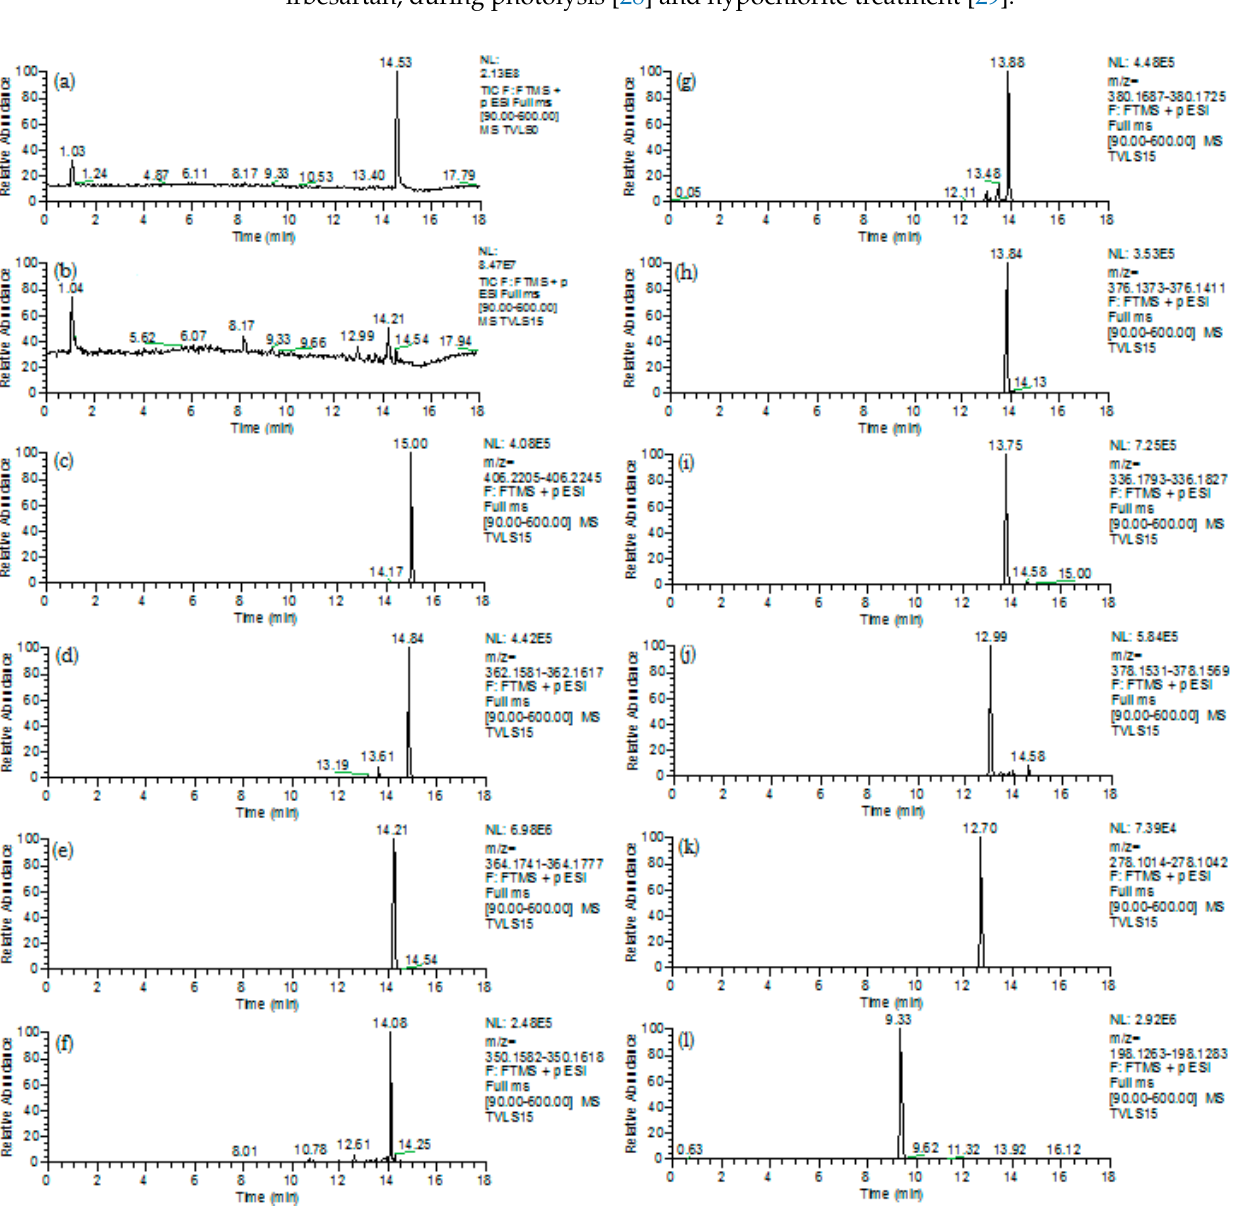
Figure 5. ( a – l ) . LC-HR-MS TPs accurate-mass extracted chromatograms of TiO 2 -photocatalytically treated (reaction time 15 min) VLS aqueous solutions.